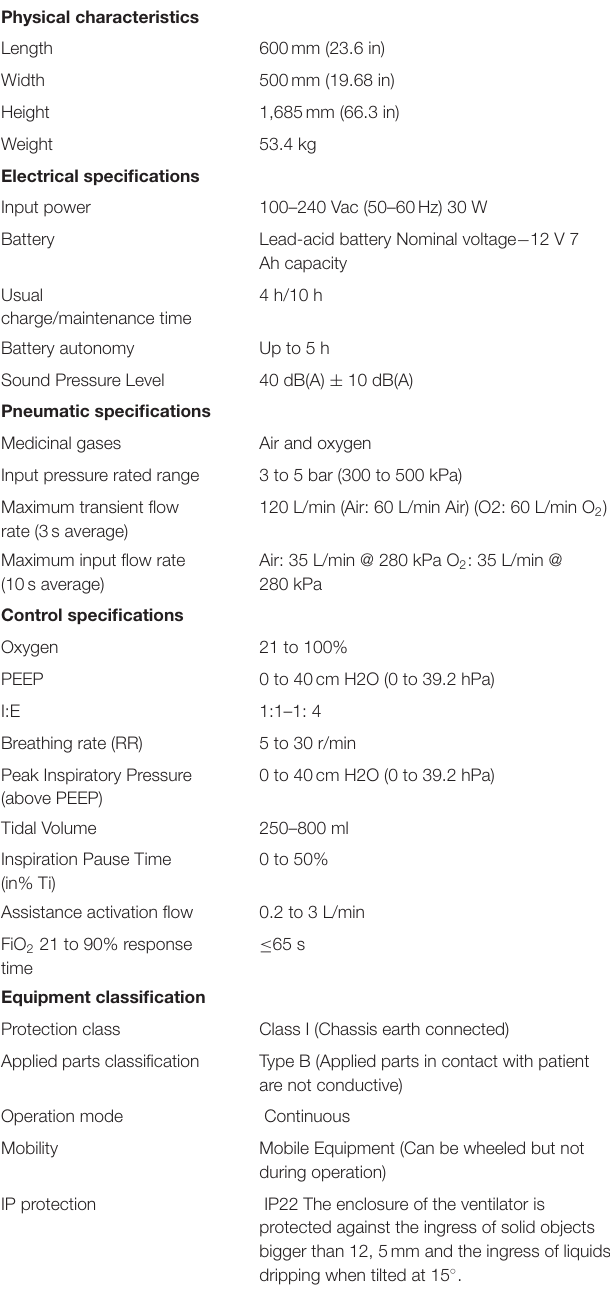
TABLE 1 | ATENA’s overall specifications and control